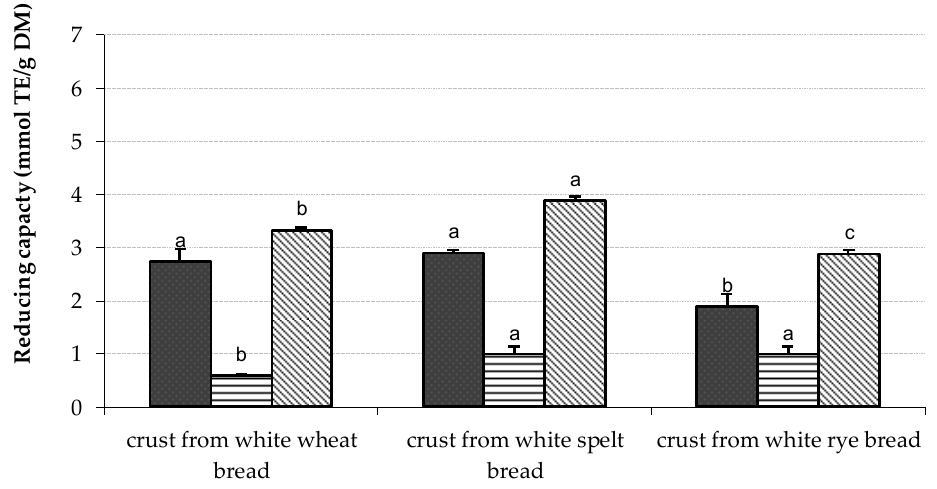
Figure 4. The total reducing capacity of crusts separated from white breads baked at 240 °C for 30 min. Data are the mean of three independent replicates ± SD. Similar letter as superscripts for bars related to the reducing capacity of hydrophilic or lipophilic or TRC indicates no significant differences ( p ≤ 0.05).